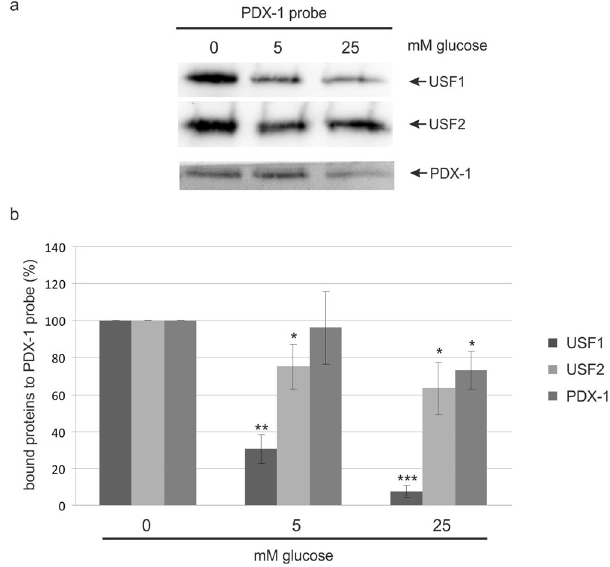
Figure 4. Pull-down assay with the PDX-1 promoter in INS-1 cells treated with glucose. One mg of nuclear extract from INS-1 cells, who had been treated with 0 mM, 5 mM or 25 mM glucose for 4 h, was incubated with 1 μ g of a biotinylated PDX-1 DNA probe. The DNA-protein complex was passed through a μ Macs ™ -column and loaded on a 10% SDS polyacrylamide gel for Western blot analysis. ( a ) Identification of USF-binding at the PDX-1 promoter was performed with the USF1 specific antibody sc-8983 and with the USF2 specific antibody sc-862. PDX-1 was visualized with the polyclonal rabbit antiserum against recombinant full-length mouse PDX-1. Full-length blots are presented in Supplementary Figure S2. ( b ) Relative protein amounts of USF1, USF2 and PDX-1 bound to the PDX-1 promoter DNA. The diagram shows the mean ± SD of three independent experiments. Statistical analysis was performed by using Students t-test. * Significant difference p < 0.05, ** significant difference p < 0.01, *** significant difference p <